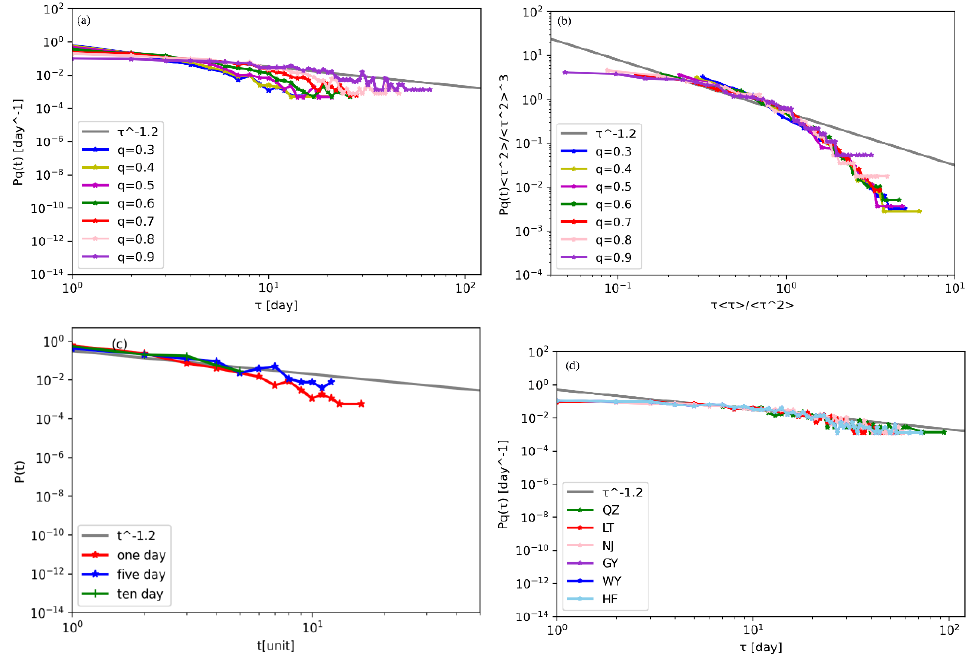
Figure 4. Probability density functions τ of precipitation events: ( a ) in different thresholds; ( b ) after rescaling; ( c ) in different time scales; (Beijing Station) ( d ) in different stations (Quzhou, Leting, Nanjing, Ganyu, Wanyuan, Hefei).